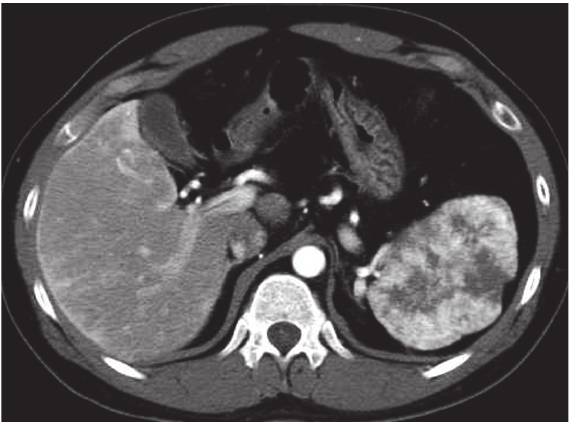
Figure 1: Arterial phase of enhanced CT, showing a 9 cm hypervascular mass in the enlarged spleen of the patient.